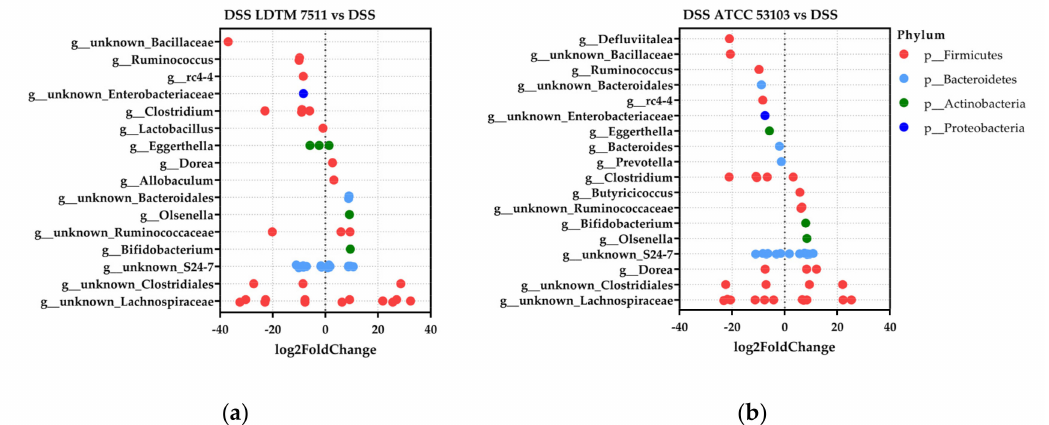
Figure 6. Di ff erential abundance determined using the DESeq2 package. Compared to the DSS group, log2 fold-change in ( a ) DSS LDTM 7511 and ( b ) DSS ATCC 53103 groups. Criteria for inclusion: mean of normalized counts for all samples (BaseMean) > 1 and Benjamini–Hochberg adjusted p value (padj) < 0.05; n = 8 in each